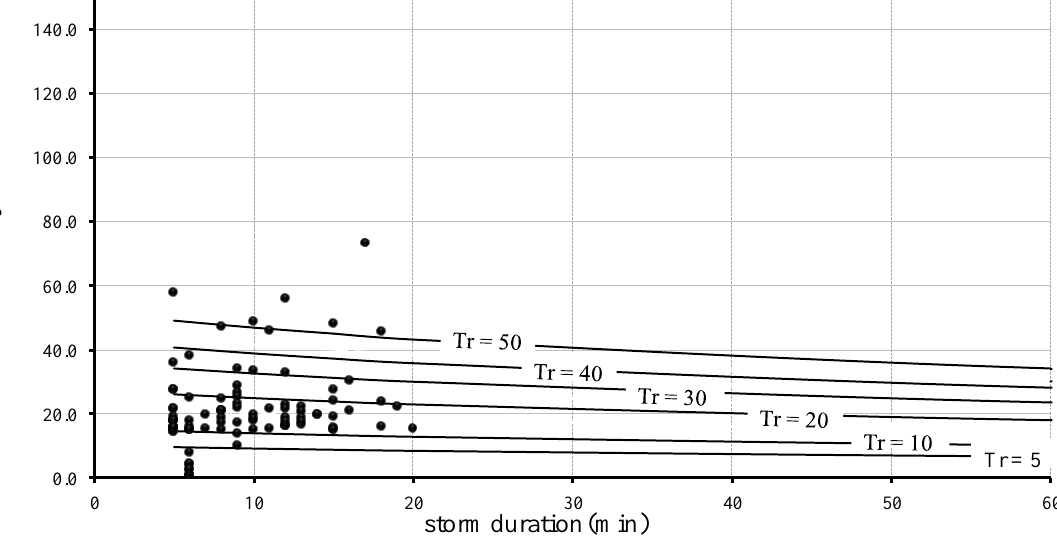
Figure 2. Traditional representation of an IDF curve at station CH-03. k = 51.55; m = 0.53; n = 0.53; θ = 1; C = 50.